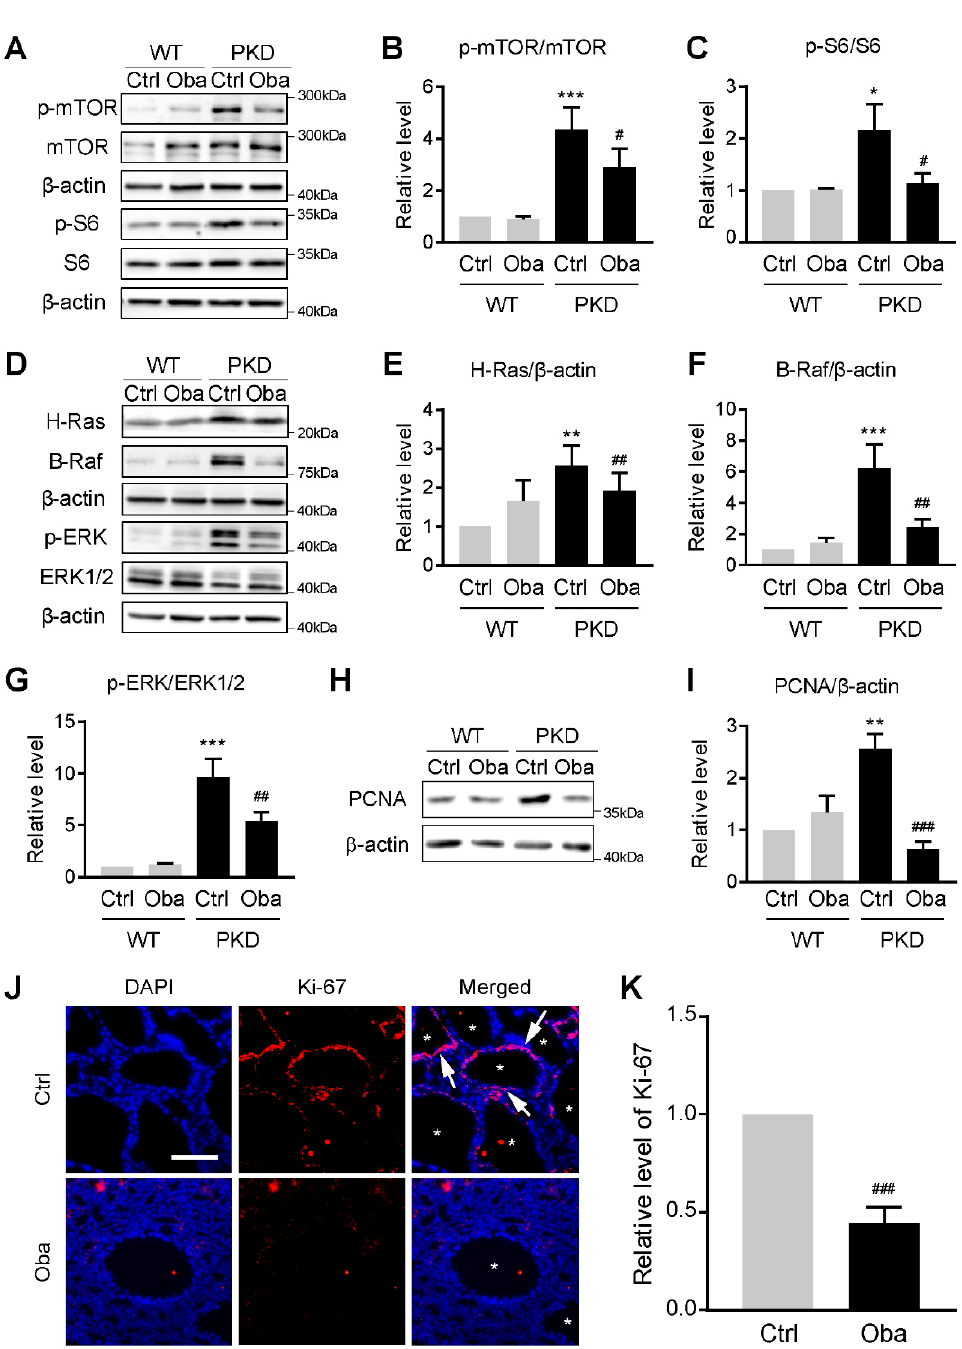
Figure 7. Inhibitory effect of obacunone on abnormal cell proliferation. ( A ) Representative Western blots of mTOR signaling pathway proteins in the kidneys of wild-type (WT) and PKD mice (PKD) treated without (Ctrl) or with obacunone (Oba). ( B ) Relative phosphorylation levels of mTOR protein. ( C ) Relative phosphorylation levels of S6 protein. ( D ) Representative Western blots of MAPK signaling pathway proteins. ( E ) Quantification of H-Ras protein expression levels. ( F ) Quantification of B-Raf protein expression levels. ( G ) Relative phosphorylation levels of ERK protein. ( H ) Representative Western blots of PCNA. ( I ) Quantification of PCNA protein expression levels. ( J ) Immunofluorescence staining of Ki-67 (red) and DAPI (blue) in the PKD kidneys. Arrows represent the Ki-67 positive cells, asterisks represent the cyst area. Bar = 50 μ m. ( K ) Quantification of Ki-67 positive cells. Data are presented as means ± SEM. n = 6. * p < 0.05, ** p < 0.01, *** p < 0.001 versus WT-Ctrl. # p < 0.05, ## p < 0.01, ### p < 0.001 versus PKD-Ctrl.